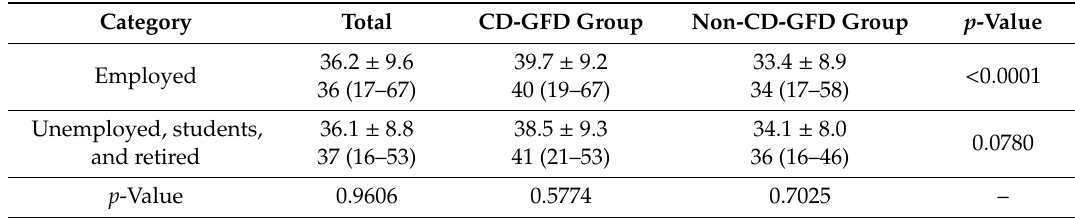
Table 8. Food Neophobia Scale (FNS) scores stratified by employment status in the sub-groups of CD-GFD and non-CD-GFD individuals (mean ± SD and median accompanied by range).